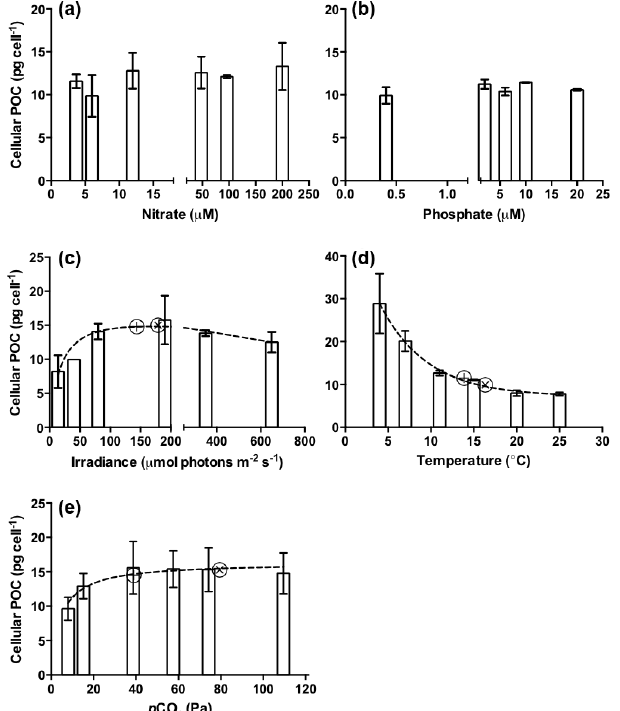
Figure 2. Changes in Emiliania huxleyi cellular particulate inor- ganic carbon (PIC) content in response to different environmental drivers: (a) cellular PIC vs. nitrate concentration, (b) cellular PIC vs. phosphate concentration, (c) cellular PIC vs. irradiance, (d) cel- lular PIC vs. temperature, and (e) cellular PIC vs. p CO 2